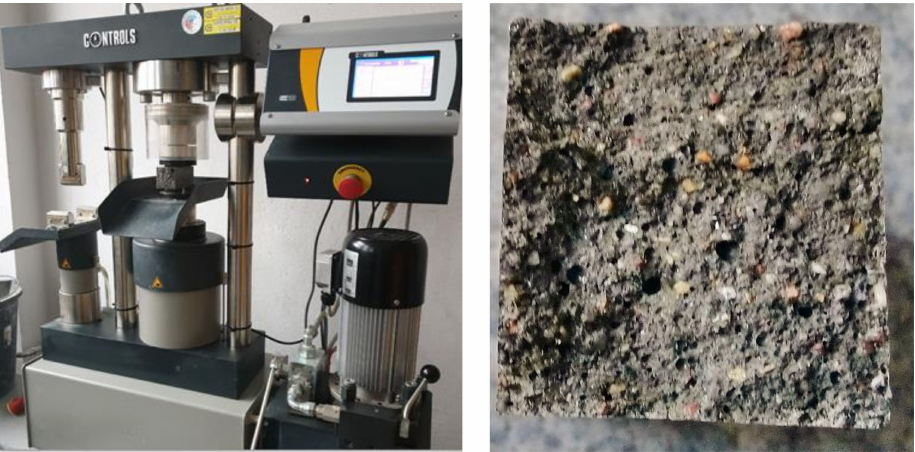
Figure 10. The view of compressive strength and tensile strength testing of mortars in the automatic apparatus and sample fracture structure (authors’ photo).